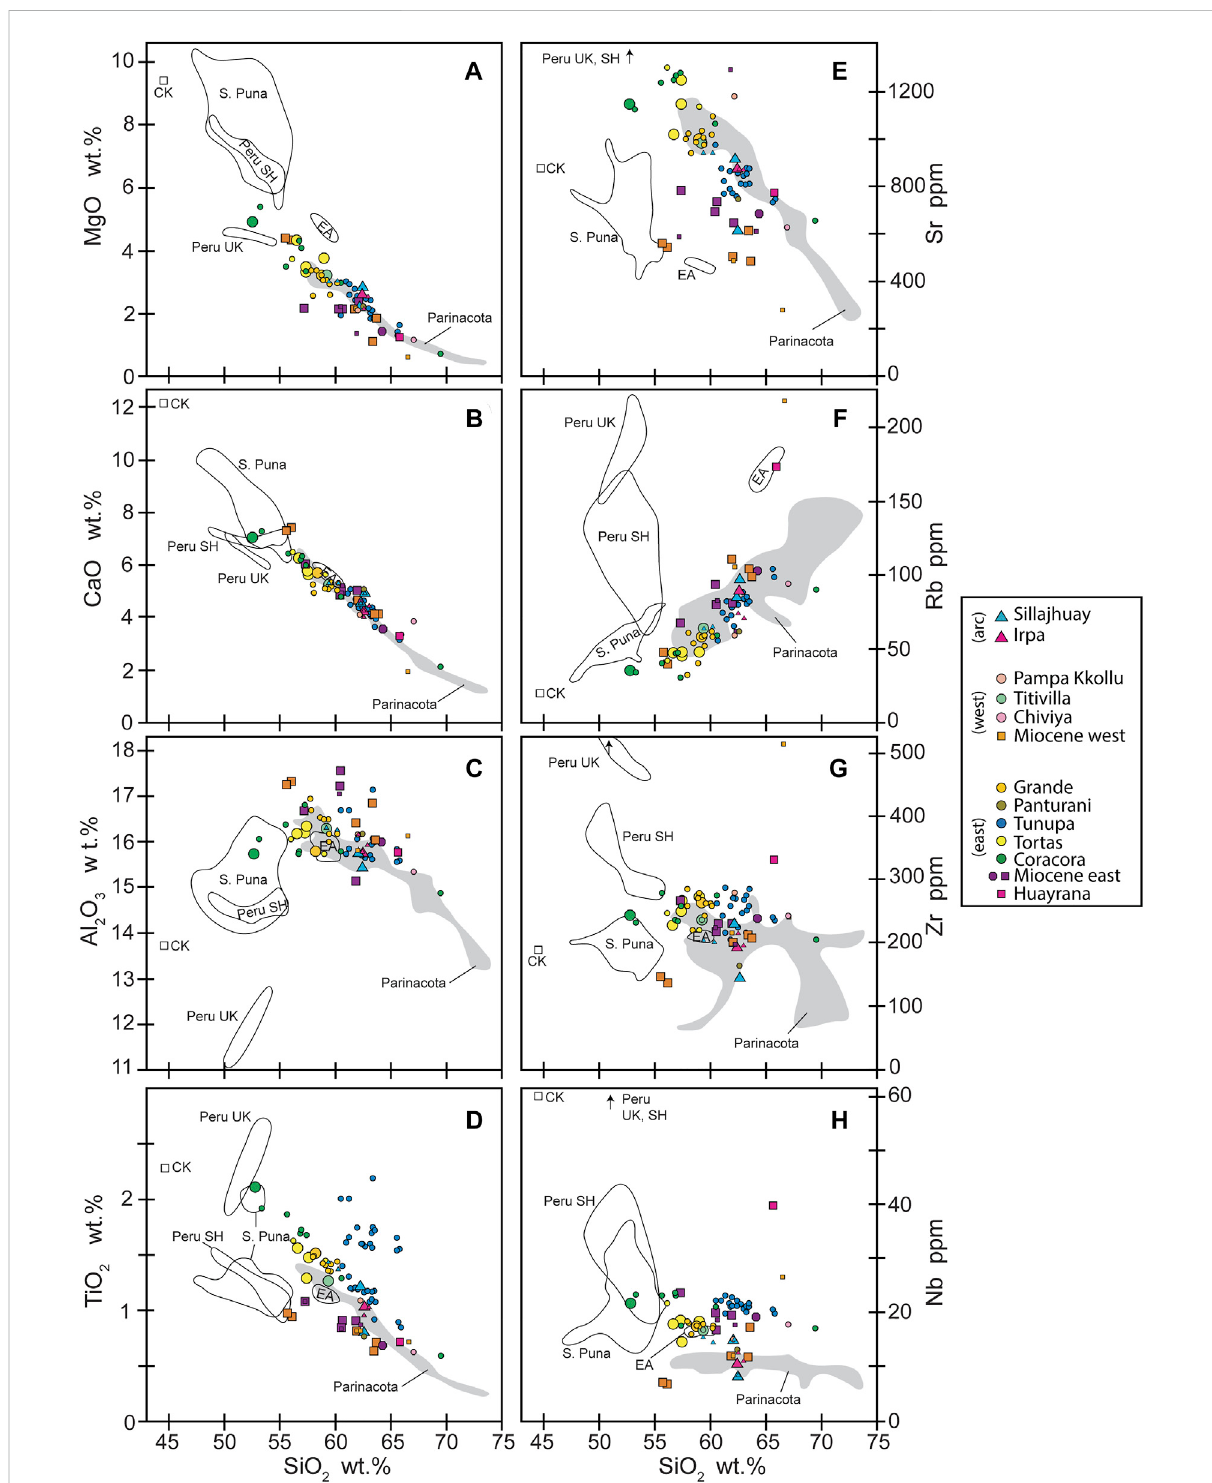
FIGURE 8 Selected Harker diagrams of Intersalar Range lavas. Compositional fi eld of Parinacota volcano shown for comparison to a well-studied CVZ compositevolcanoofthemainarc(Horaetal.,2009).Selectreararclavasoftheplateauarealsoshownforcomparison(samereferencesasFigure7). Reararc TiO 2 and Nb values exhibit the largest deviation from the Parinacota array. Note that shoshonitic (SH) and ultrapotassic (United Kingdom) lavas from the Peruvian reararc (Carlier et al., 2005) are extremely enriched in trace elements and plot off the diagrams of Sr, Zr, and Nb. Larger symbols from the current study represent data with 40 Ar/ 39 Ar age